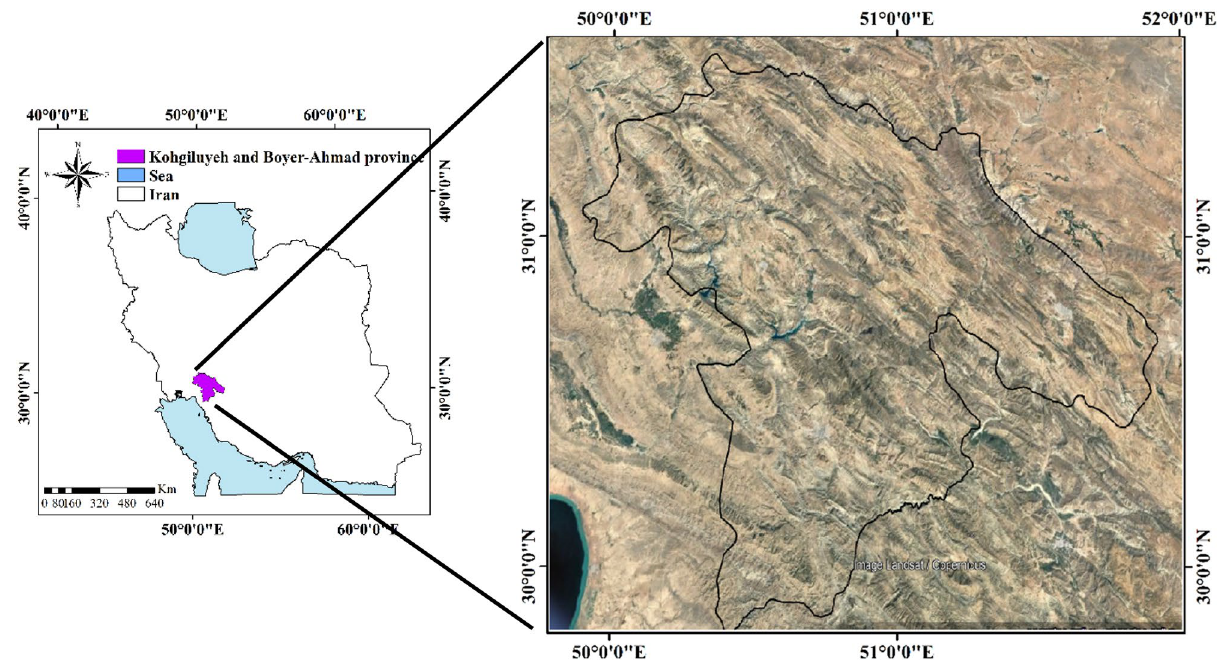
Figure 8. Location of the Kohgiluyeh and Boyer-Ahmad Province in